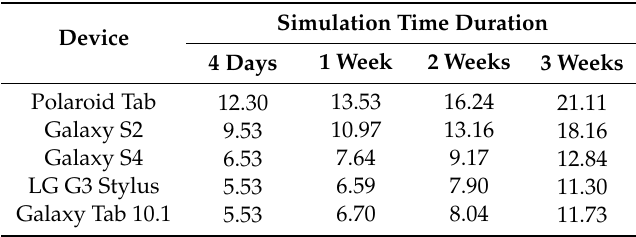
Table 6. Time to complete computation of glucose concentration plots (in seconds) using several simulation time